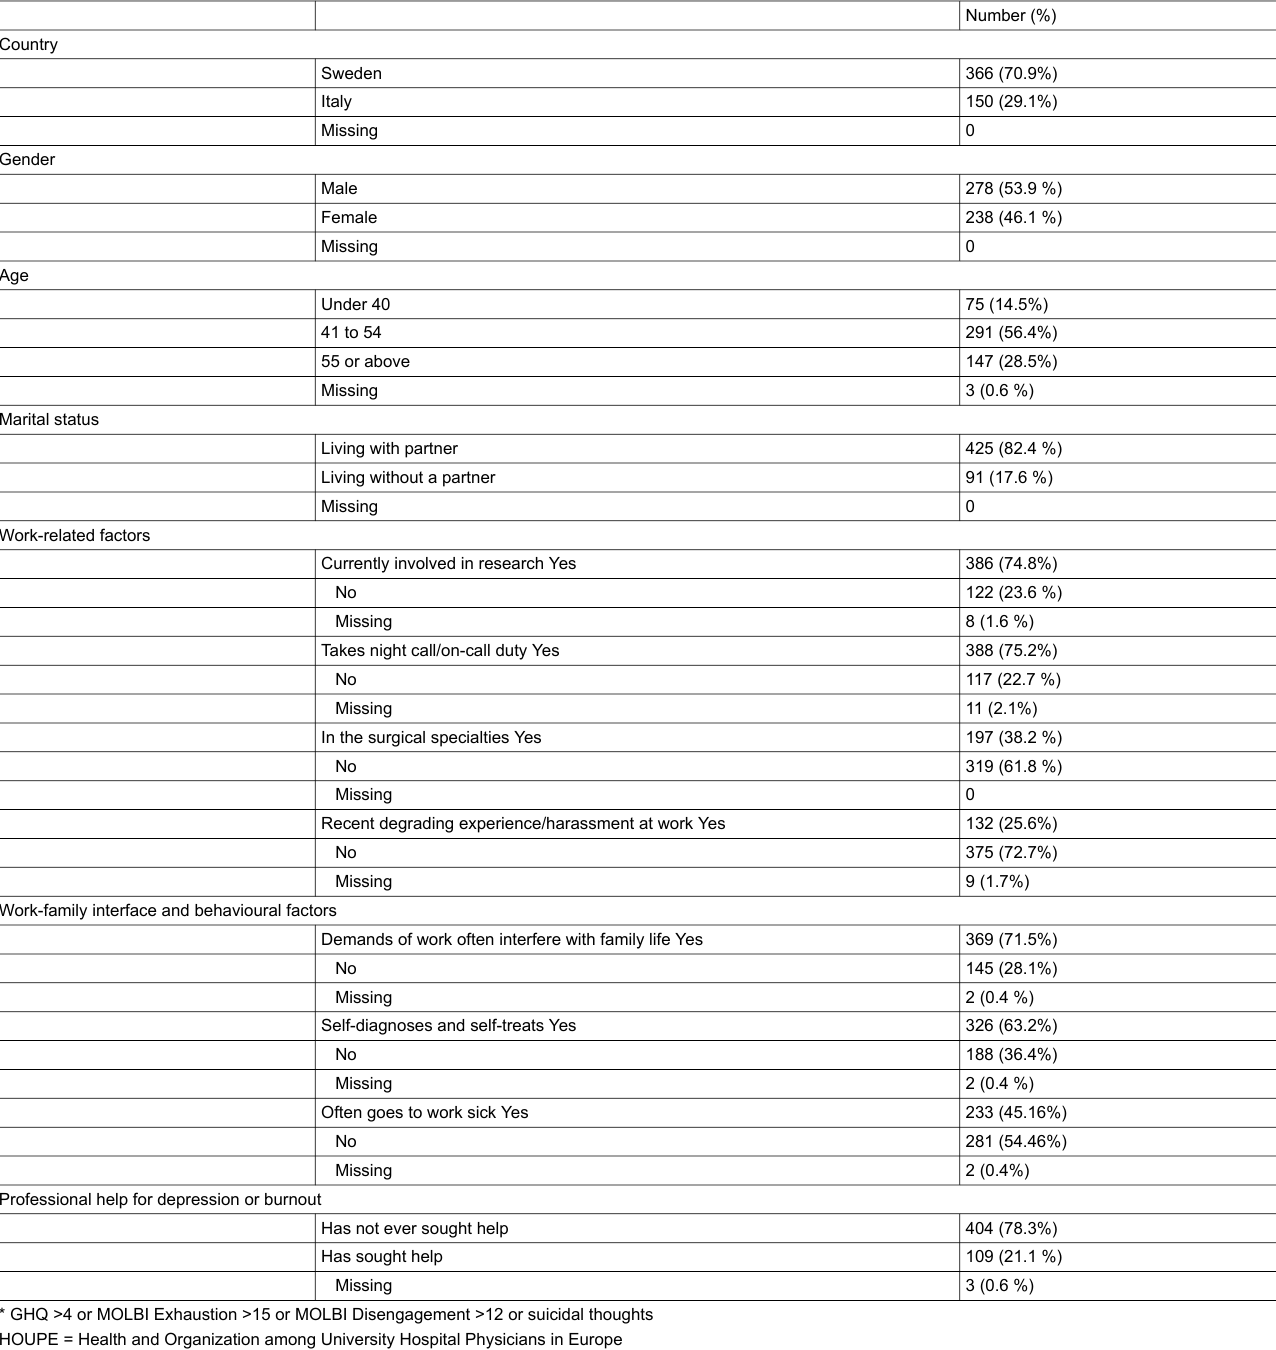
Table 1: Characteristics of the physicians included in the present analyses: University hospital physicians with one or more indicators of current psychological ill-health* and who participated in the HOUPE I study.